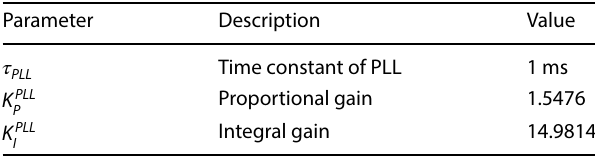
Fig. 5 Uncontrolled RESM plant